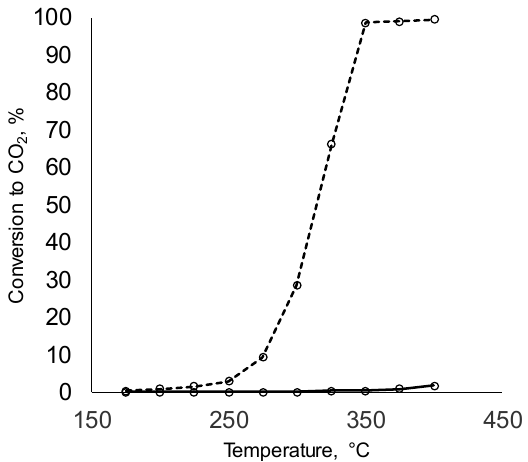
Figure 1. Light-off curve of CO 2 production from 1,2DCP combustion. Dashed line: 30/CoSBA. Figure 1. Light ‐ off curve of CO 2 production from 1,2DCP combustion. Dashed line: 30/CoSBA. Full Full line: SBA-15 line: SBA ‐ 15 support.